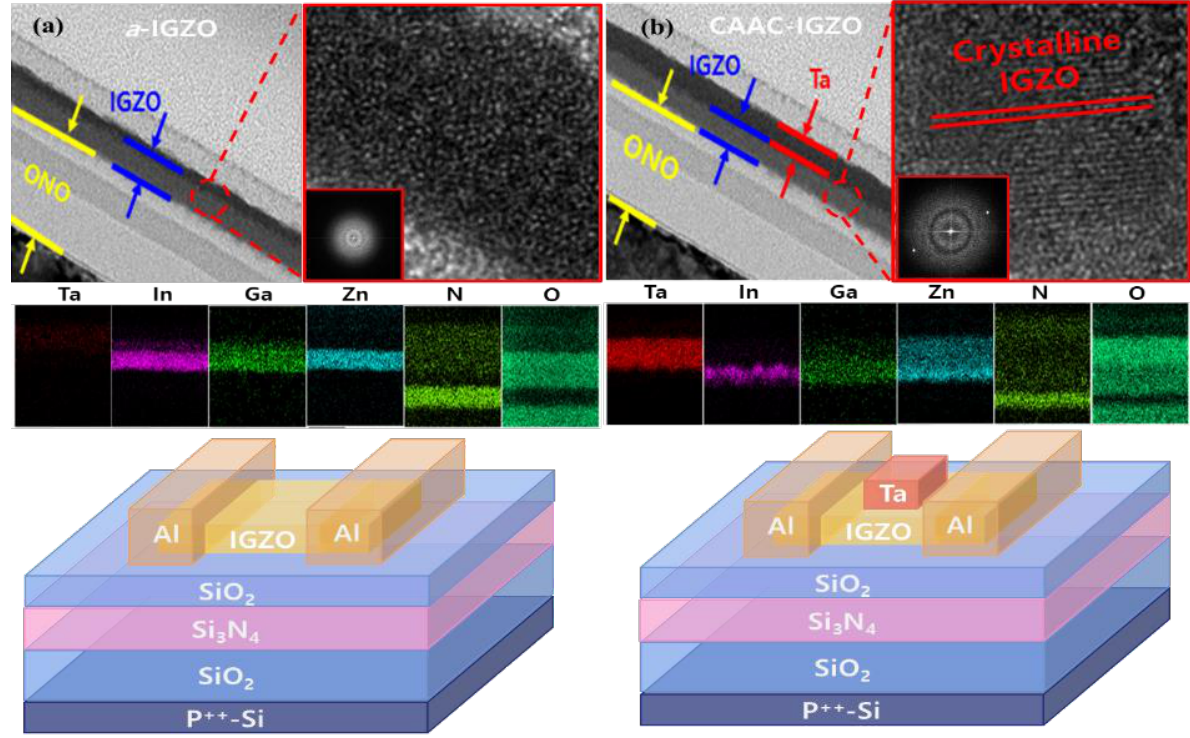
Figure 3. Cross-sectional flash memory TEM images and device schemes with ( a ) a -IGZO and ( b ) CAAC-IGZO layers.